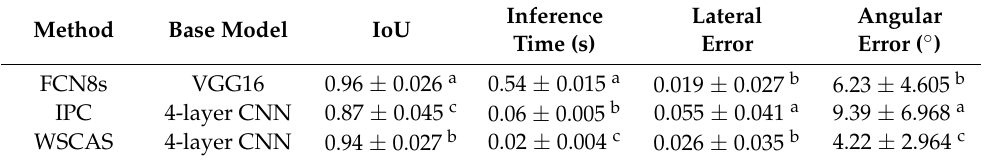
Table 1. Statistical comparison of the performances by the segmentation